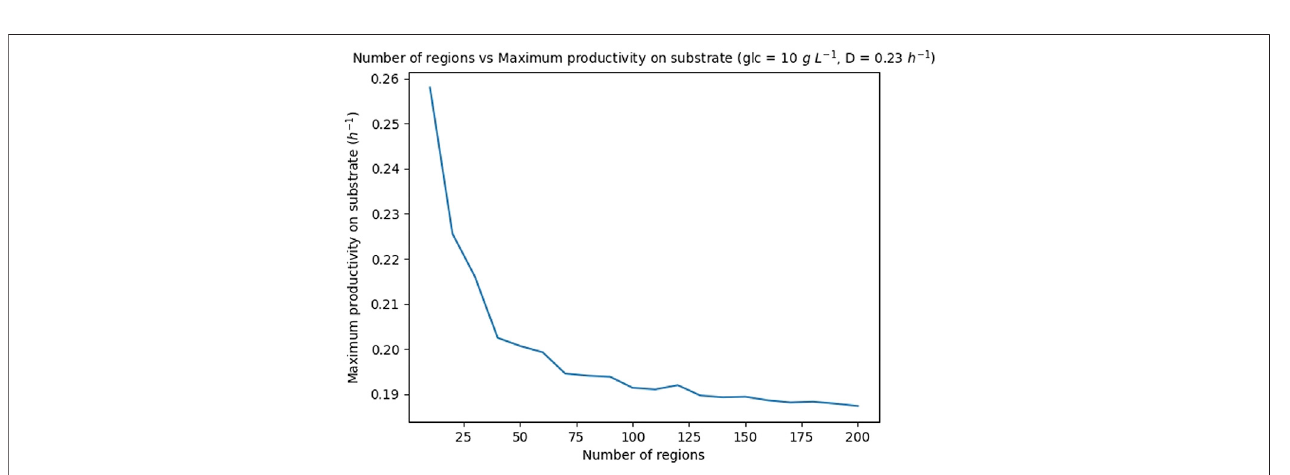
FIGURE 7 | Theoretical maximum productivity on substrate PS with respect to the number of regions in which the biomass is partitioned. The glucose concentration is set to 10 g L − 1 and the dilution rate to 0.23 h − 1 .